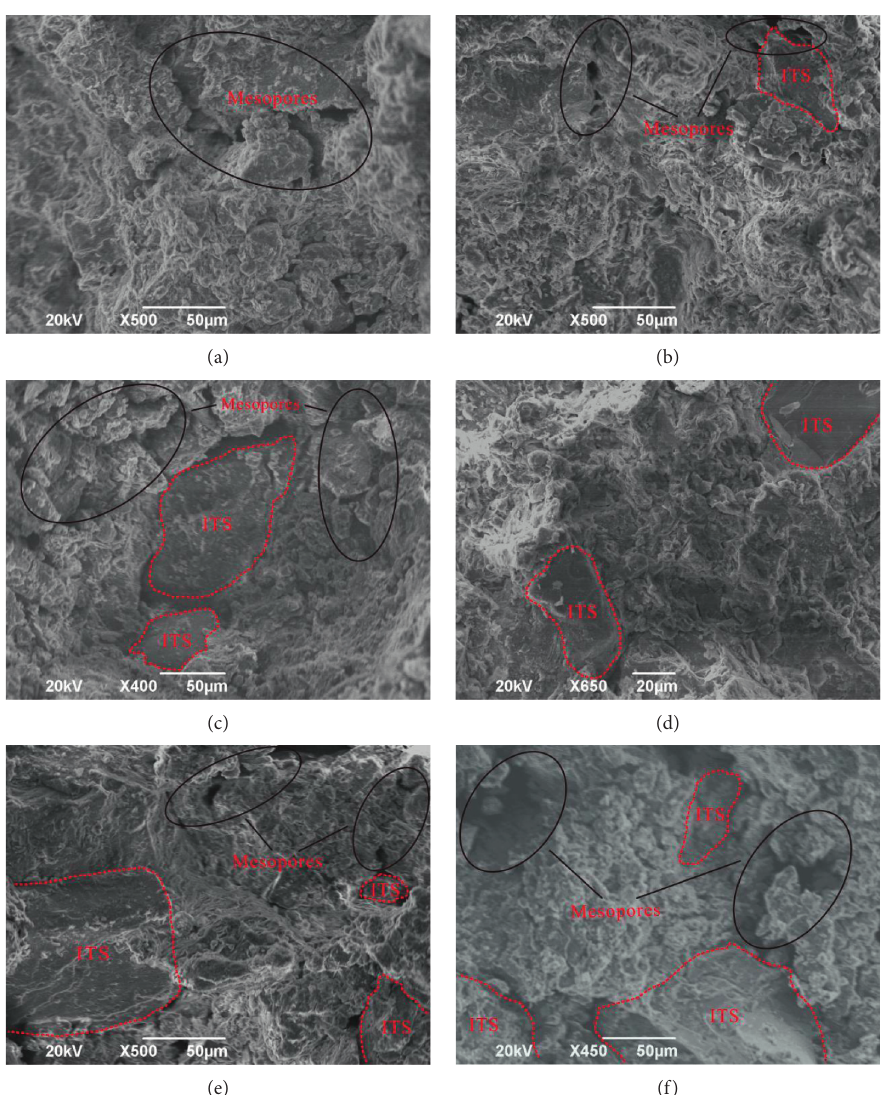
Figure 11: Microstructure of the soil samples before and after modification. (a) Natural soil. (b) 10% ITS. (c) 20% ITS. (d) 30% ITS. (e) 40% ITS. (f) 50%